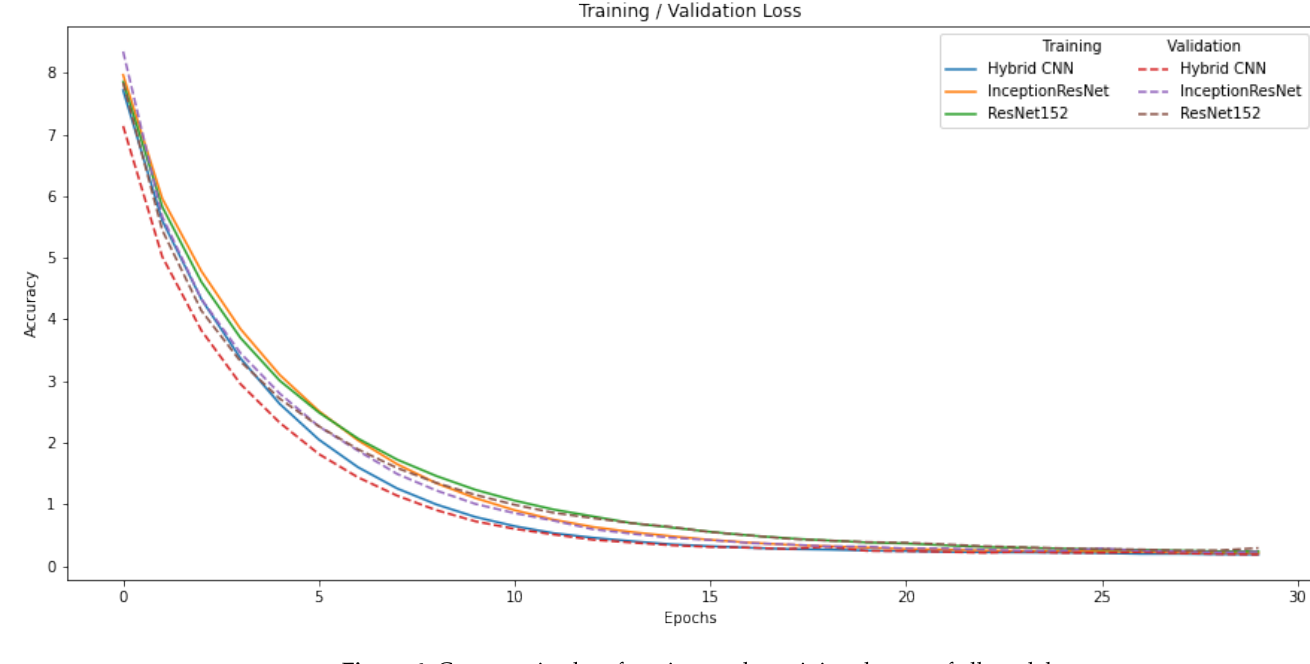
Figure 6. Comparative loss function on the training dataset of all models.